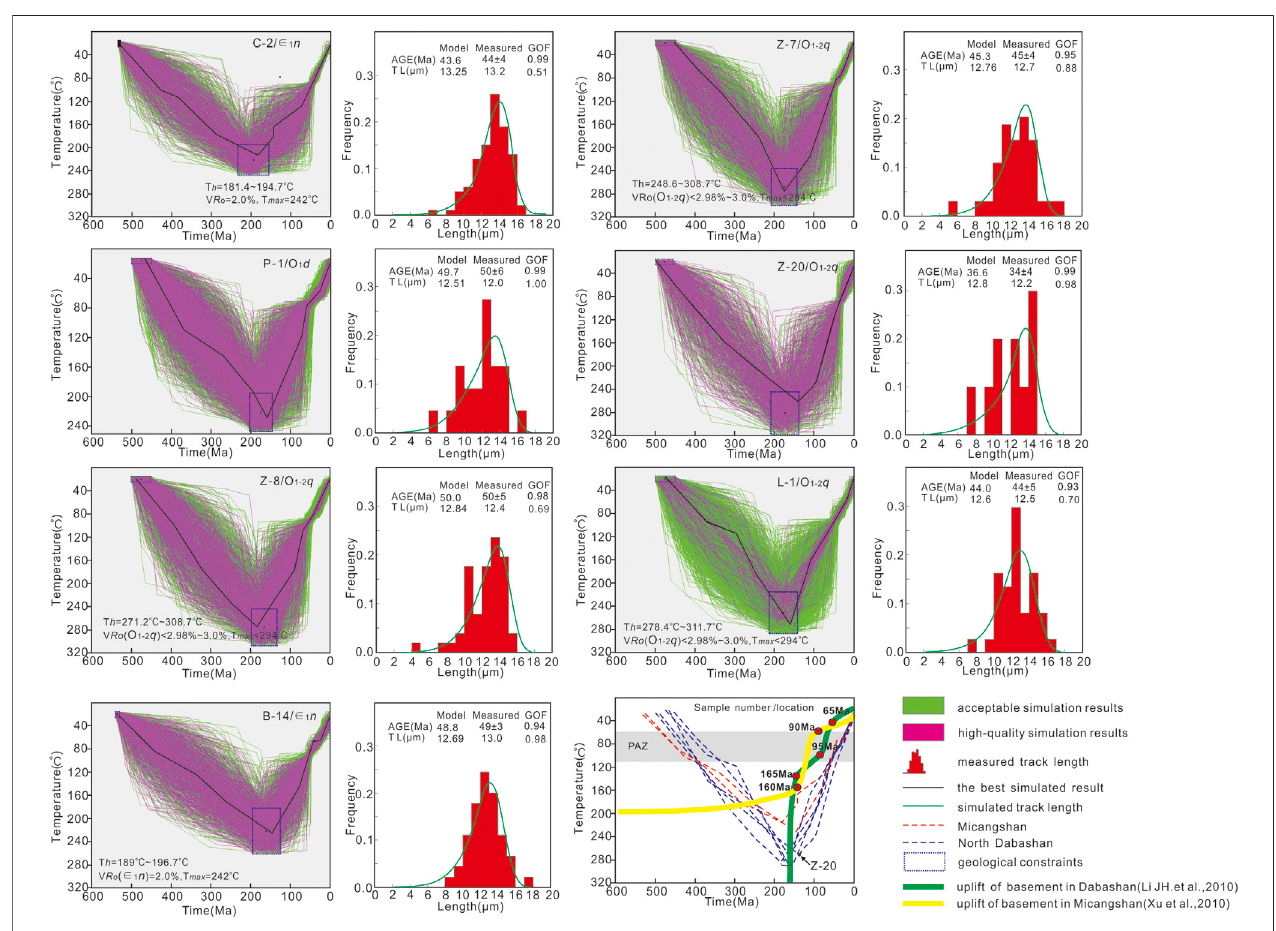
FIGURE 6 | Results of thermal history modelling based on apatite fi ssion track (AFT) data using HeFTy for samples from the Micangshan and Dabashan tectonic belts. The rapid cooling time of sample Z-20 near the Chengkou fault was later than the others, which may indicate the cooling event in the Dabashan area was gradual from northeast to southwest